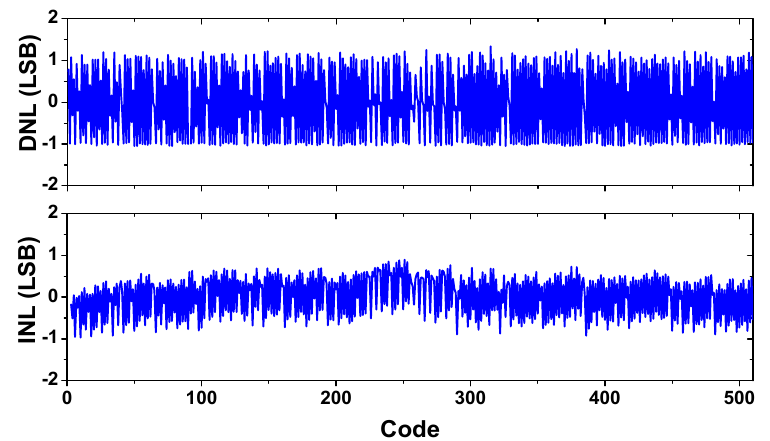
Figure 16. Measured static performance of the ADC.